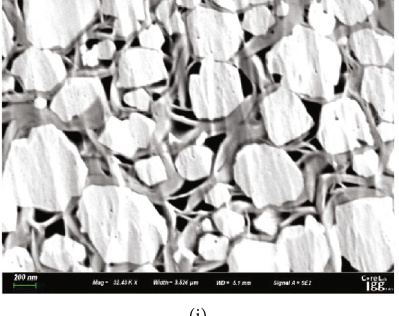
Figure 8: Field emission scanning electron microscope (FE-SEM) images of shale samples. (a, b) Sample 2165.67, TOC = 6 : 32 % , organic matter-hosted pores are developed in small part of organic matter; (c) sample 2166.73, TOC = 10 : 02 % , organic matter-hosted pores are undeveloped, and organic matter shrinkage fractures can be found locally; (d, e) sample 2167.09, TOC = 10 : 0 % , organic matter-hosted pores are rich (d) and undeveloped in di ff erent organic matter (e); (f) sample 2167.69, TOC = 9 : 64 % ; (g) sample 2168.13, TOC = 9 : 03 % ; (h) sample 2181.46, TOC = 2 : 70 % ; (i) sample 2193.56, TOC = 1 : 79 % . (f) – (i) show various kinds of inorganic pores, including clay mineral interlayer fractures (f – h) and pyrite intergranular pores (i).